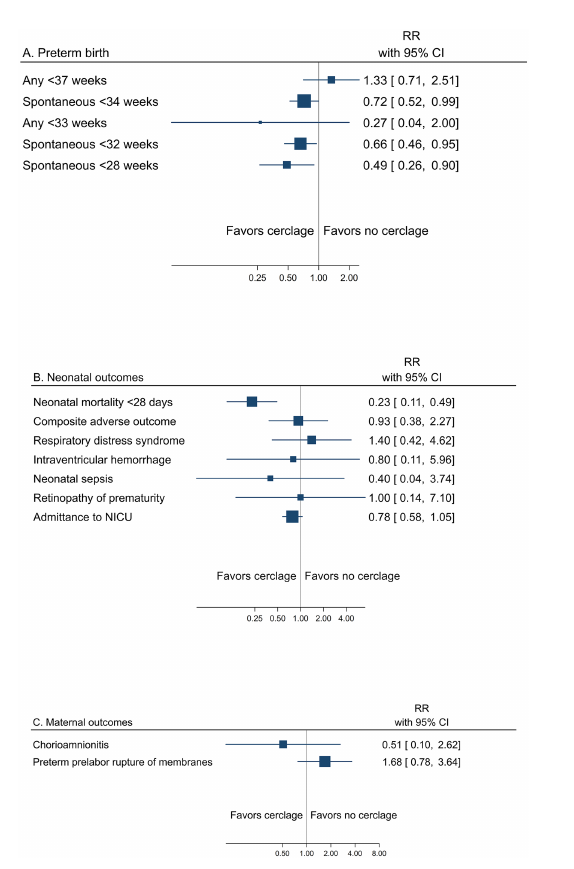
FIGURE 6 Summary graph of pooled estimates from meta-analyses comparing cerclage versus no cerclage in women with a multifetal pregnancy with or without additional risk factor(s) for preterm birth from trials with low risk of bias regarding (A) preterm birth, (B) neonatal, and (C) maternal outcomes.